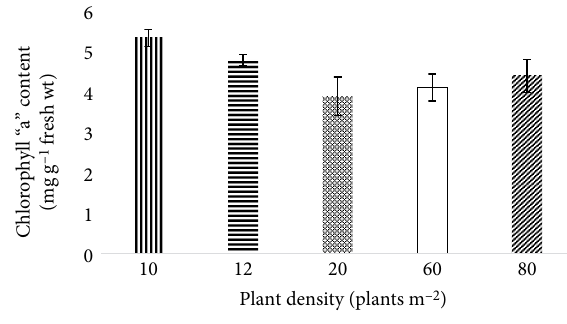
Figure 1: Effect of plant density on chlorophyll “a” content of soybean leaves. Vertical bars represent ± standard error. Values significantly different at 푝 < 0.05 . Table 3: Effect of plant density and cultivar on intercepted photo- synthetically active radiation (IPAR) at 50% flowering